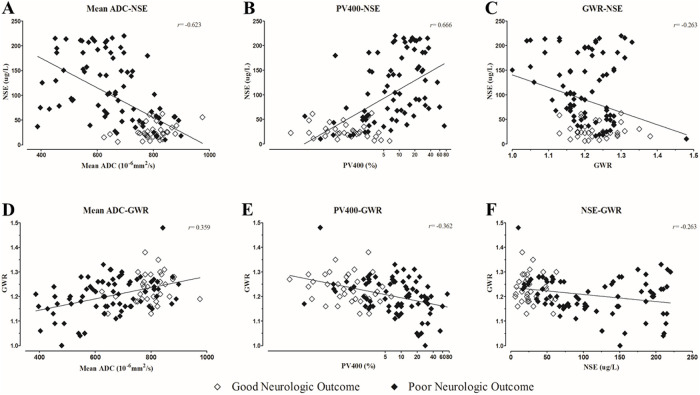
Correlations between NSE and imaging parameters using Spearman’s correlation coefficient.A: Mean ADC-NSE correlation coefficient r = -0.623. B: PV400-NSE correlation coefficient r = -0.666. C: GWR-NSE correlation coefficient r = -0.263. D: Mean ADC-GWR correlation coefficient r = 0.359. E: PV400-GWR correlation coefficient r = -0.362. F: NSE-GWR correlation coefficient r = -0.263.